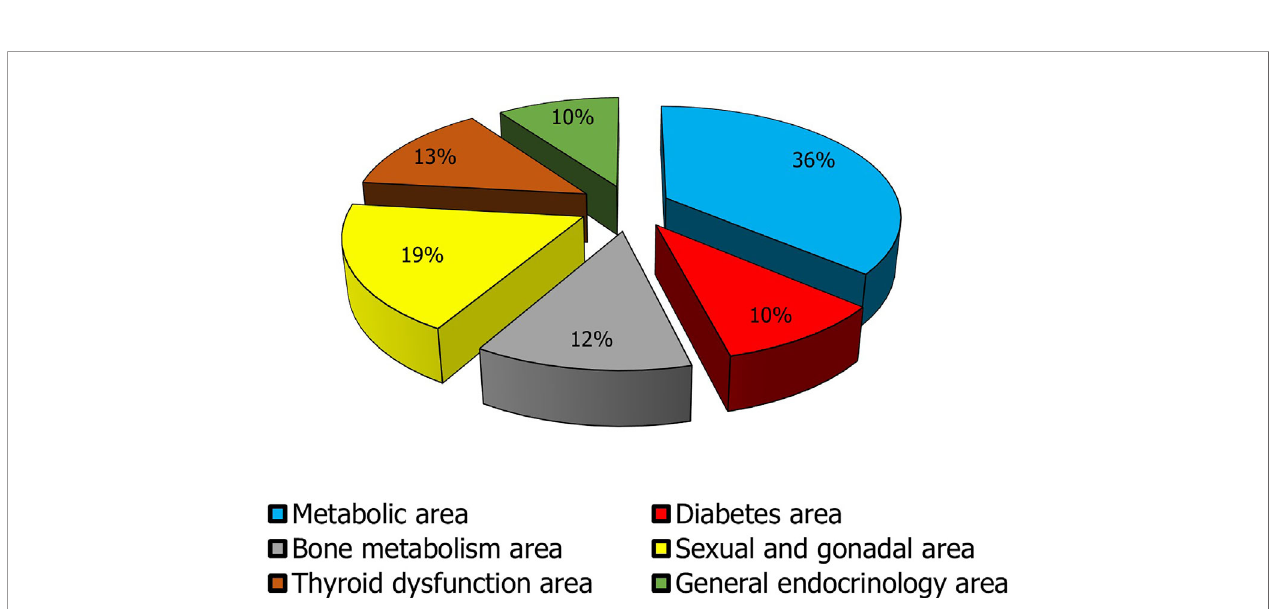
FIGURE 3 | Impact of the macro-areas of endocrine interest in clinical practice. The metabolic macro-area is given by the sum of obesity and dyslipidemia data; the diabetes mellitus area encloses DM1 and DM2 data; the bone metabolism area collects prevalence data of male and female osteoporosis, hypoparathyroidism, and hyperparathyroidism; The sexual and gonadal area includes data on male and female infertility, LOH, PCOS, POF, severe menopausal disorders, treated male and female sexual dysfunction, early and delayed puberty, and gender dysphoria; Thyroid dysfunction area includes thyroiditis, hypothyroidism, hyperthyroidism, and malignant thyroid nodule (the prevalence of ultrasonographic nodular pathology was not considered to avoid to overestimate the problem. In fact, the most clinically signi fi cant nodules are those that are malignant on cytologic and/or histologic examination); General endocrinology area encompasses data regarding pituitary adenomas, hypopituitarism, adrenal incidentaloma, Addison ’ s disease, CAH, neuroendocrine tumors, ASP, MEN.